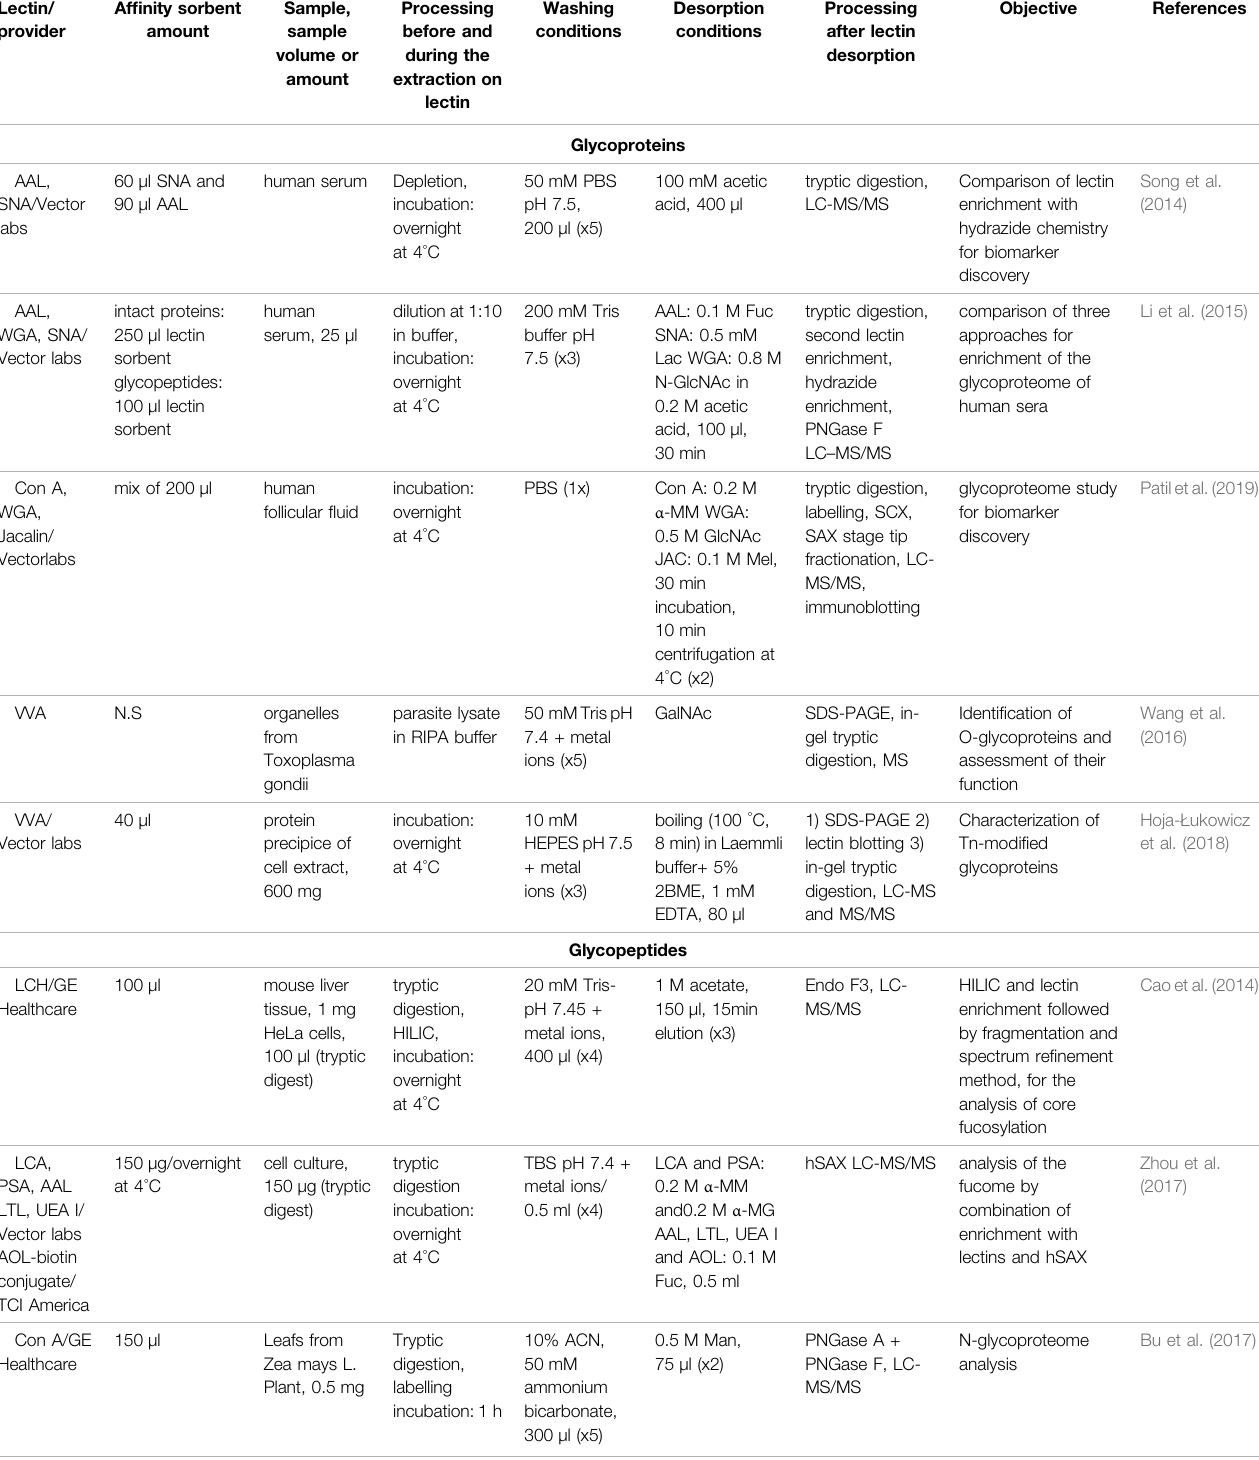
TABLE 3 | Lectin dispersive solid phase extraction using commercial sorbents. Lectin/